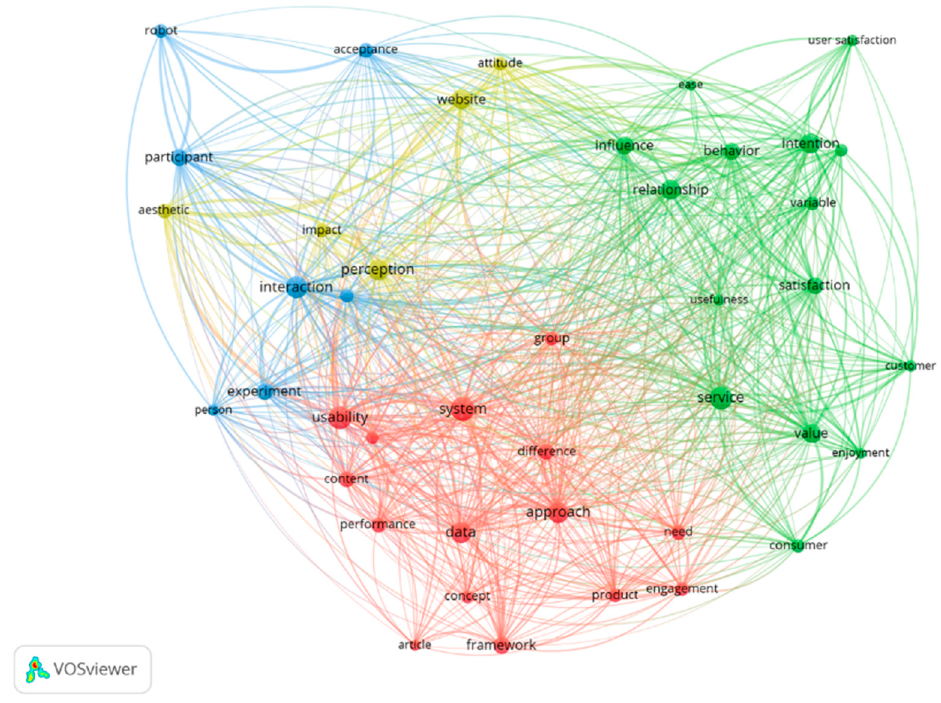
Figure 6. Topic words map. Source: Own elaboration based on VOSViewer.